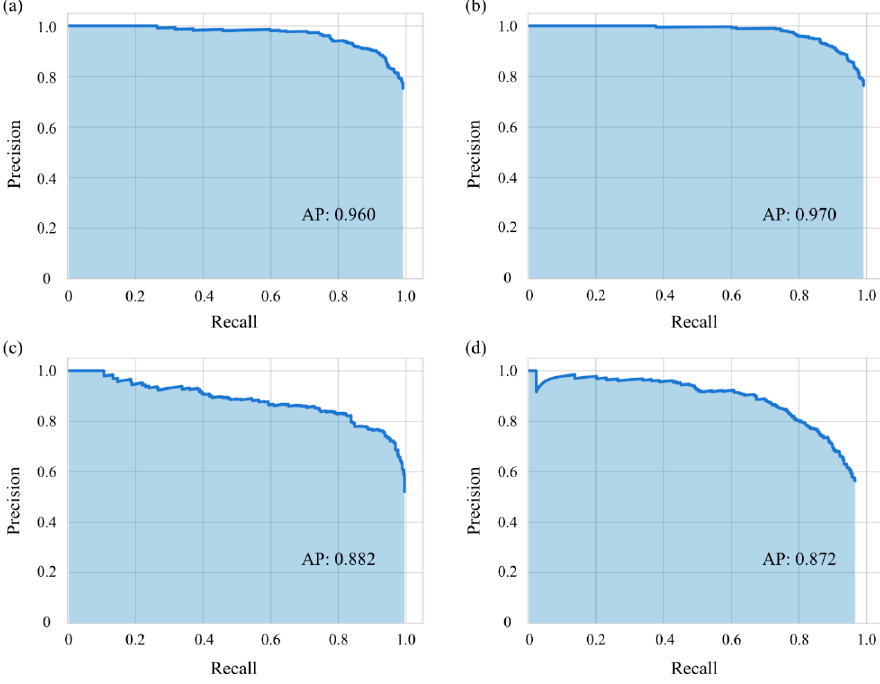
Figure 2. ( a , b ) show p-r curves demonstrating the detection performances of left and right maxillaries in Waters’ view, and ( c , d ) correspond to those of left and right in Caldwell’s view. Abbreviation: AP, average precision.